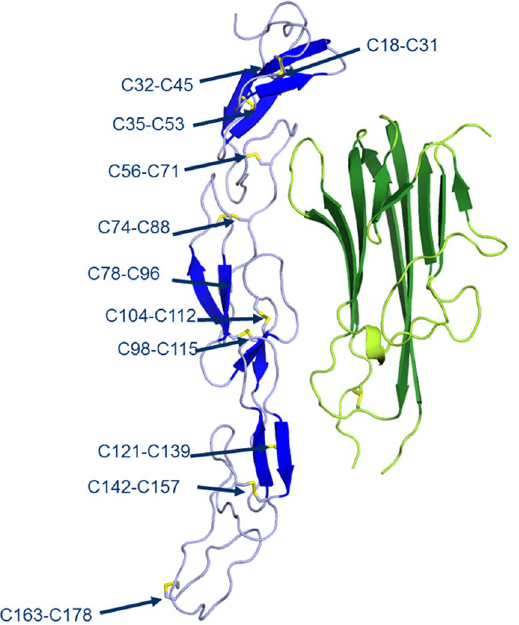
Figure 2. Disulfide bridge structures in etanercept. X-ray crystallography of the GP2015 TNF-receptor domain (blue) in conjugation with TNF α (green) was achieved and provides important structural information for etanercept. The eleven disulfide bridge structures in the receptor domain are in line with those previously reported in the literature for crystal structures of etanercept 12 . The LC-MS based triple digest peptide map (see methods for details) was able to identify each of the eleven disulfide bridge structures as well as four additional incorrect disulfide bonds between cysteines C 18 -C 74 , C 71 -C 88 , C 78 -C 88 and C 71 -C 74 in both GP2015 (Erelzi ® ) and the reference product (Enbrel ® ).